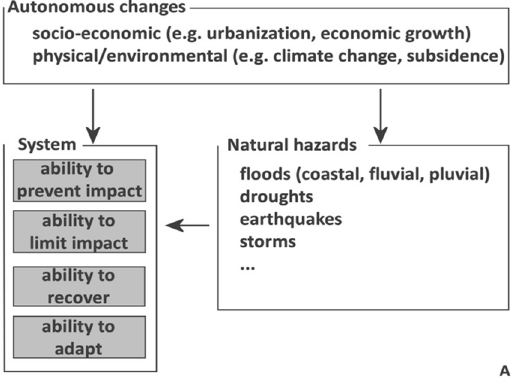
Figure 1. The four abilities which systems need to cope with flood hazards.